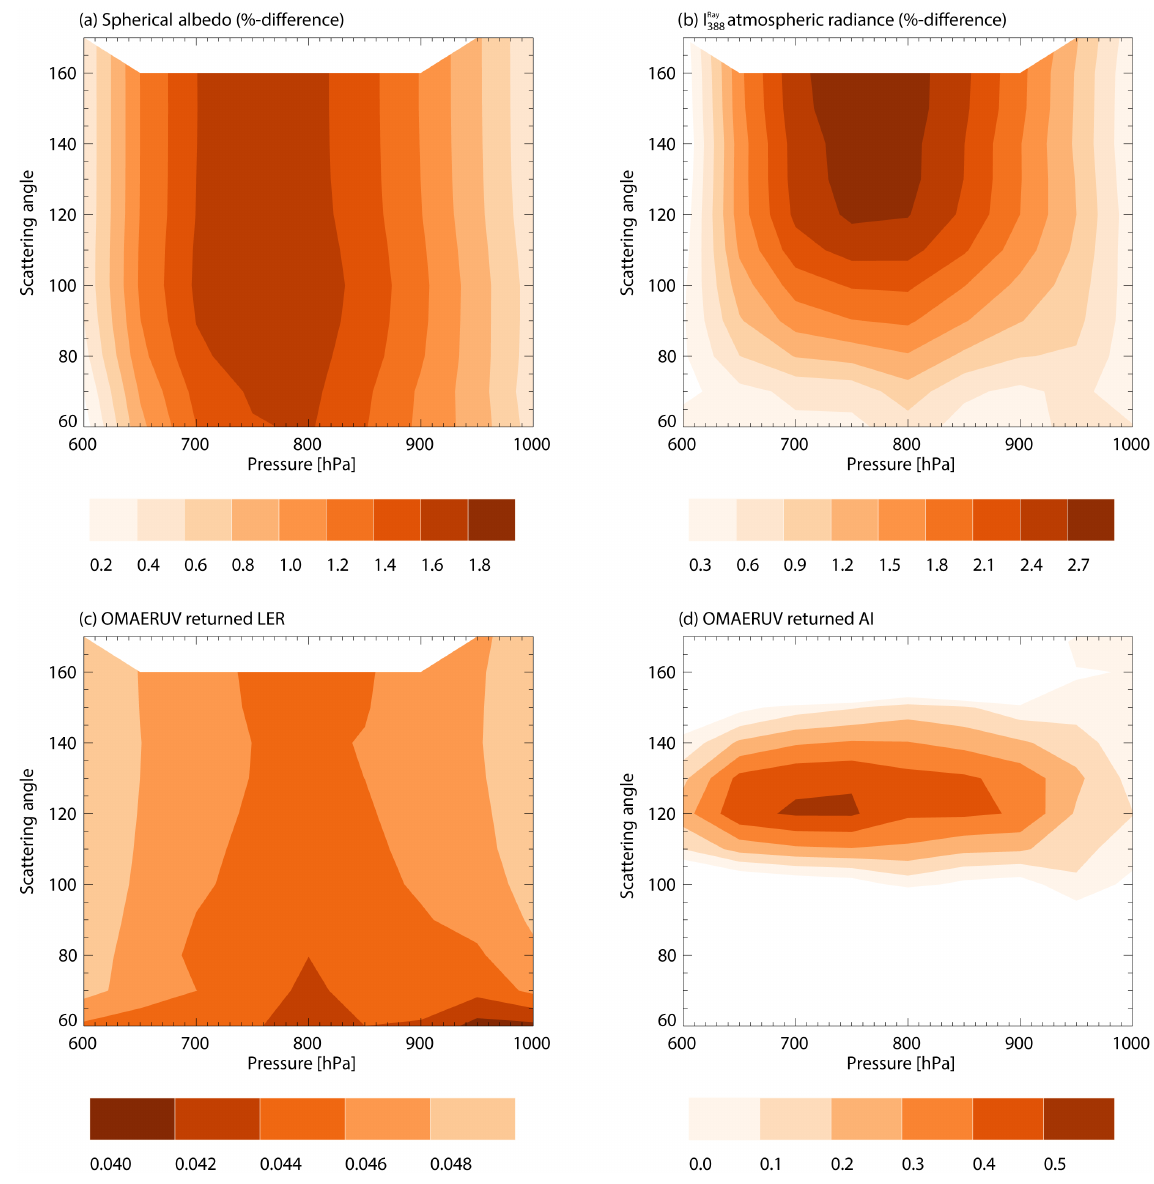
Figure 6. Results of sensitivity study exploring pressure interpolation of radiative transfer calculation results provided by OMAERUV. (a) Percent difference in spherical albedo, calculated as ( OMAERUV − MERRAero )/ MERRAero. (b) Percent difference in molecular at- mosphere radiance at 388nm, calculated as ( OMAERUV − MERRAero )/ MERRAero. (c) LER derived from OMAERUV calculations. (d) Aerosol index derived from OMAERUV